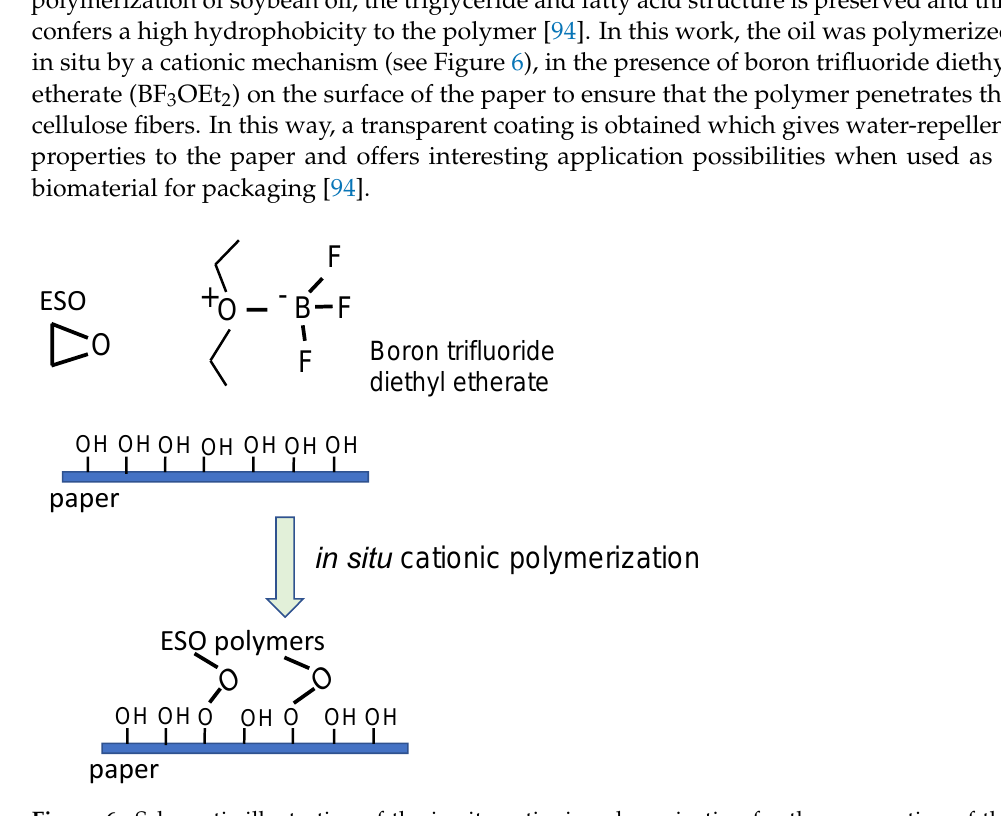
Figure 6. Schematic illustration of the in situ cationic polymerization for the preparation of the ESO-based paper composites (inspired from Miao, S et al.) [94].